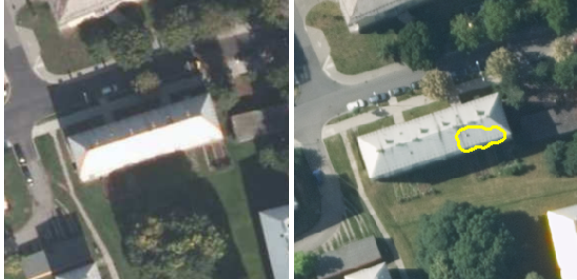
Figure 11. Left: aerial image (2010) Right: aerial image (2012)